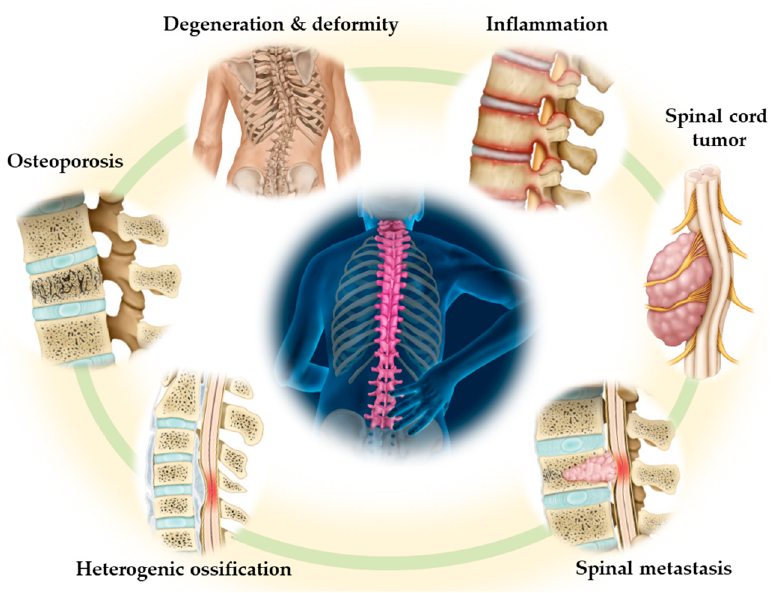
Figure 1. Typical spine-related disorders in the elderly.